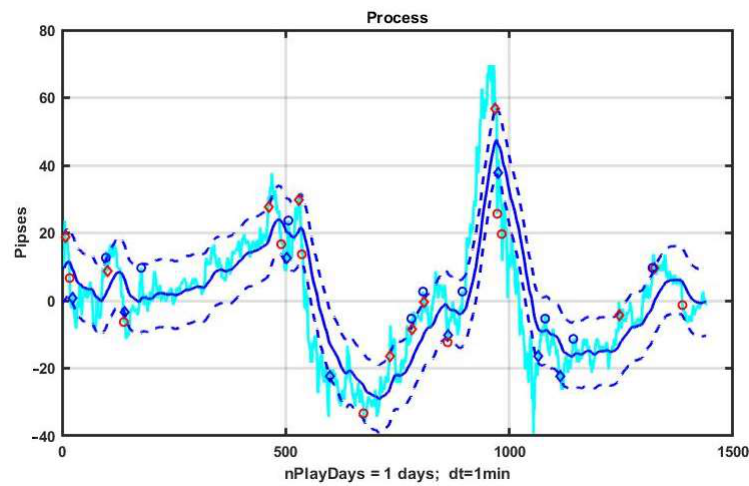
Figure 12. Performance of CSB in the example implementation.